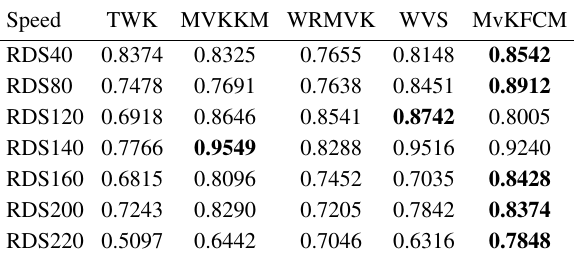
Table 3 NMI of different mutli-view